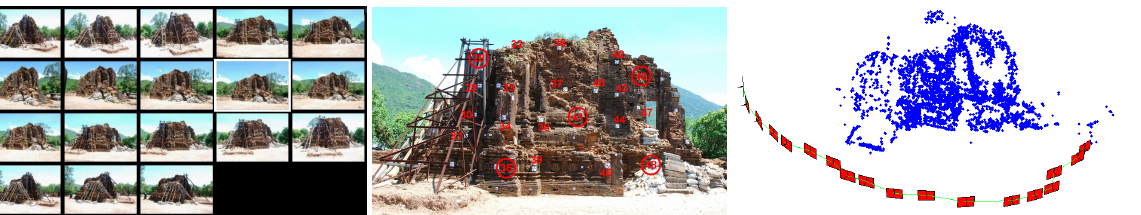
Figure 6: The Myson temple sequence. The target used for accuracy analysis with highlighted those employed as GCPs, and the recovered camera poses of the sequence.